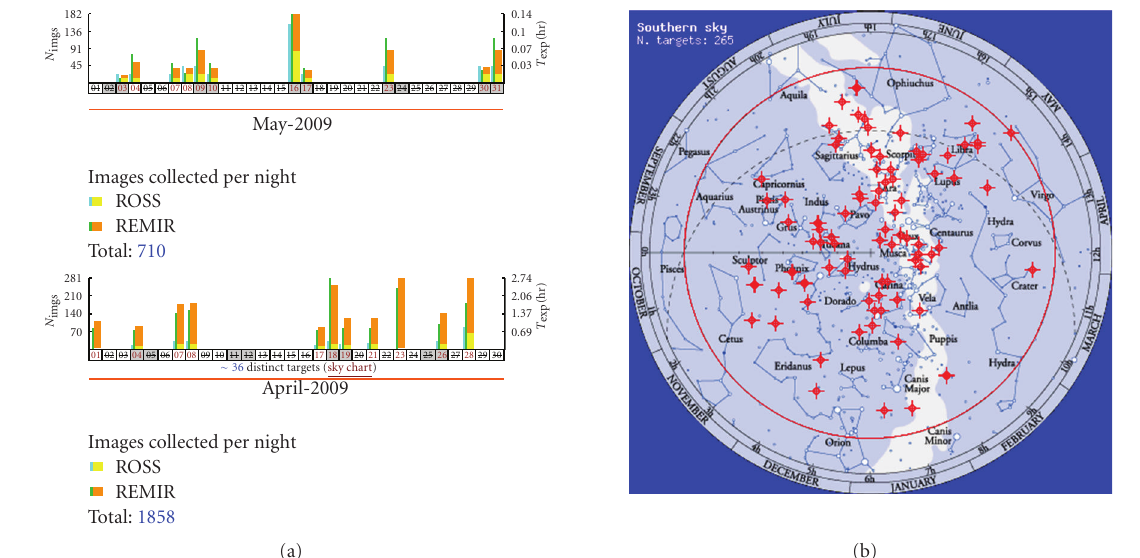
Figure 7: The REM archive browser allows PI and general public to select and retrieve observed targets. A limited statistical analysis can be performed on the fly: on the upper part of (a) all the flat field frames in the month of May 09, in the lower part of (a) the GRB observations during April 09. The sky chart on (b) the position in the southern hemisphere of all GRBs in the year